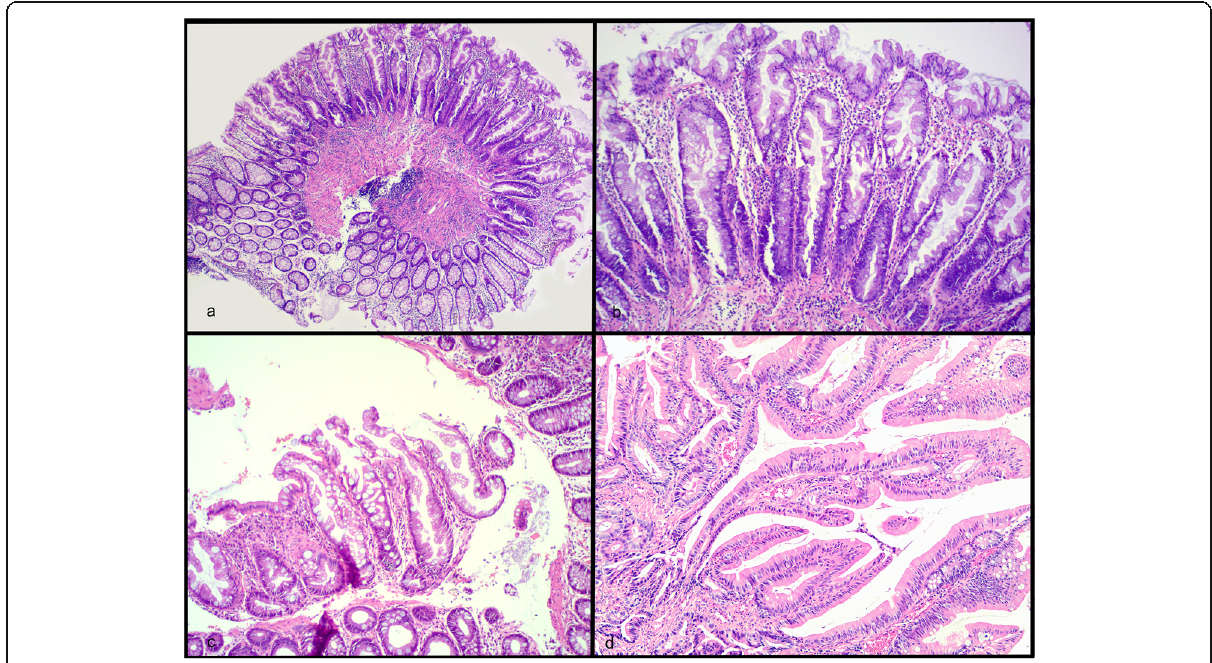
Fig. 1 H&E stain. ×40 hyperplastic polyp ( a ), ×100 hyperplastic polyp showing superficial and crypt serration limited to the upper two-thirds ( b ) , × 100 sessile serrated polyp with boot- shaped crypt ( c ), × 100 traditional serrated adenoma with conspicuous eosinophilic cytoplasm, loss of mucin, and pencillate nuclei ( d